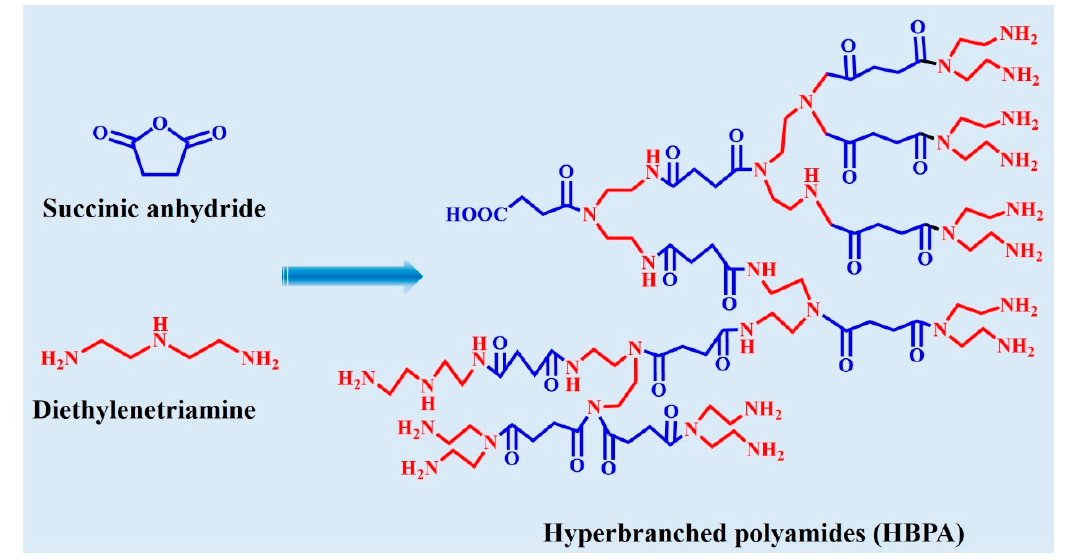
Scheme 2. Chemical reaction synthesis of HBPA.